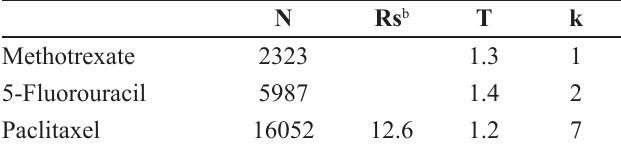
TABLE II - System suitability parameters a calculated for antineoplastic drug determination with C18 column (250 x 4.6 mm, 5 µM) and a mobile phase consisting of